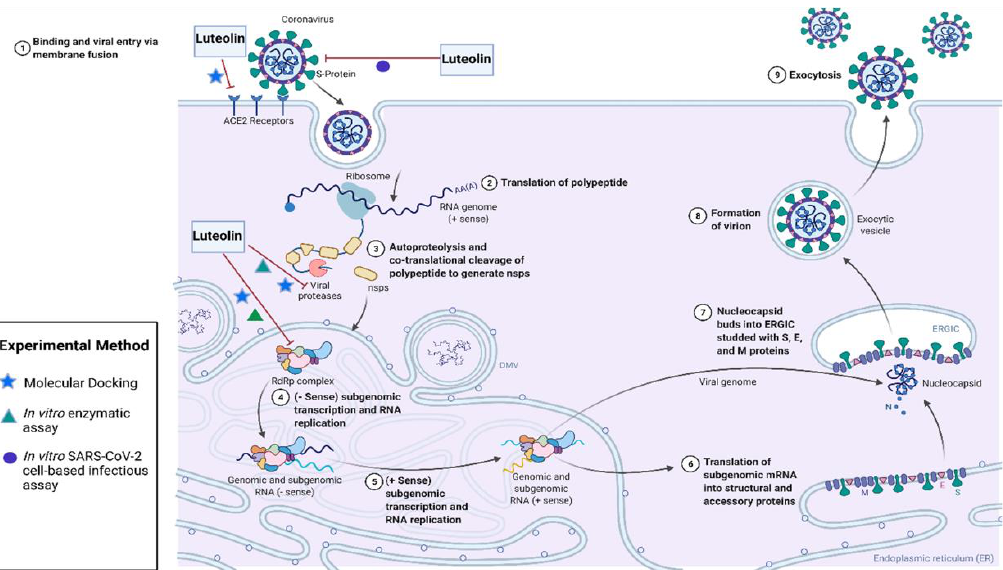
Figure 2. Luteolin is a potential anti-viral against SARS-CoV-2, and could be an effective therapeutic for COVID-19. Luteolin binds to S protein, and inhibits the binding of SARS-CoV-2 to ACE2. Luteolin binds with high affinity to SARS-CoV-2 main protease (Mpro), papain-like protease (PLpro), RNA-dependent RNA polymerase (RdRp) and ACE2 as shown by molecular docking studies. The inhibitory activity of luteolin for Mpro and RdRp has been confirmed by enzymatic assays. This figure was adapted from “ Life Cycle of Coronavirus ” , by BioRender.com (2022), with modifications. Retrieved from https://app.biorender.com/biorender-templates (accessed on 27 January 2022)